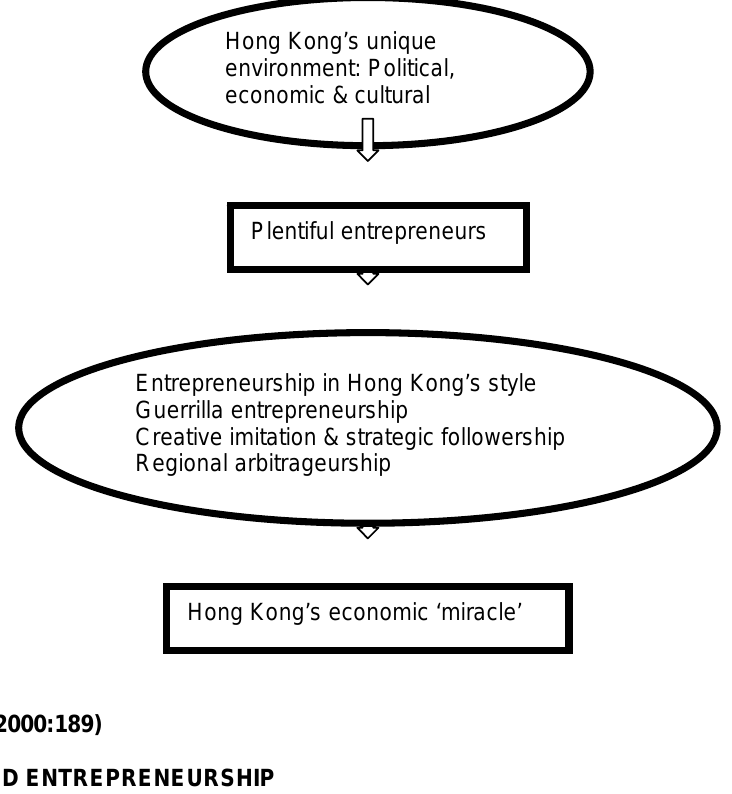
Figure 1: Entrepreneurial model of Hong Kong’s economic